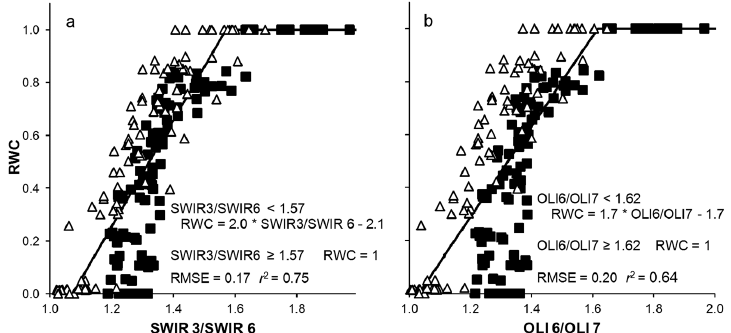
Figure 7. RWC for crop residues and soils as a function of two water indices based on satellite band ratios: ( a ) SWIR3/SWIR6 for WorldView-3; and ( b ) OLI6/OLI7 for Landsat. The spectral bands are: